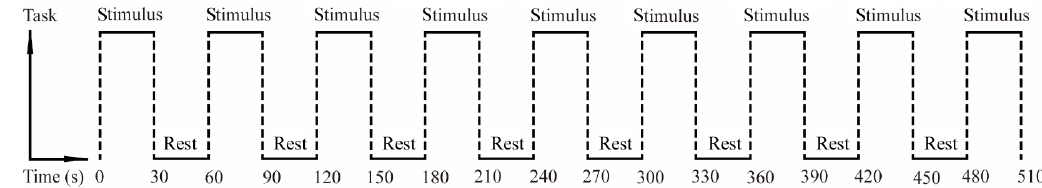
Fig. 4 Schematic of the block